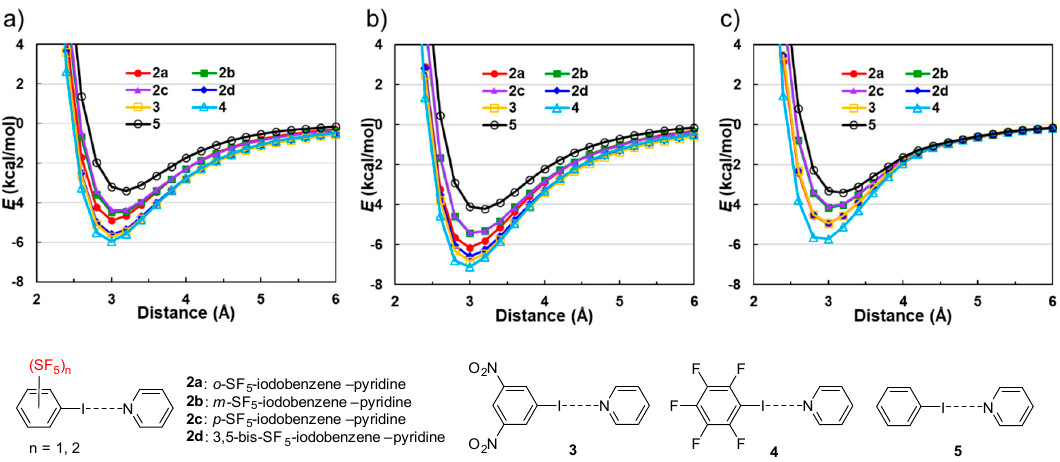
Figure 3. Interaction energy curves (energies versus I—N distance ( R )) calculated for the iodobenzene—pyridine complexes ( 2 – 5 ). ( a ) second order Møller–Plesset perturbation calculations (MP2; vacuum), ( b ) Becke, 3-parameter, Lee–Yang–Parr calculation with Grimme’s D3 dispersion correction (B3LYP-D3, vacuum), and ( c ) B3LYP-D3 (water).